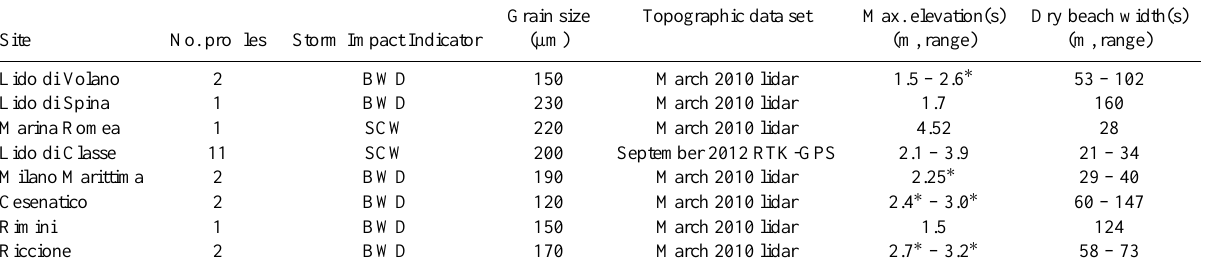
Table 1. Summary of the eight different sites incorporated into the Emilia-Romagna early-warning system.